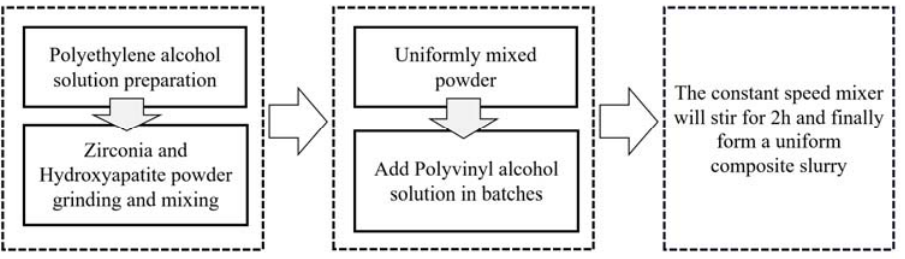
Figure 1. Preparation process of composite slurry.